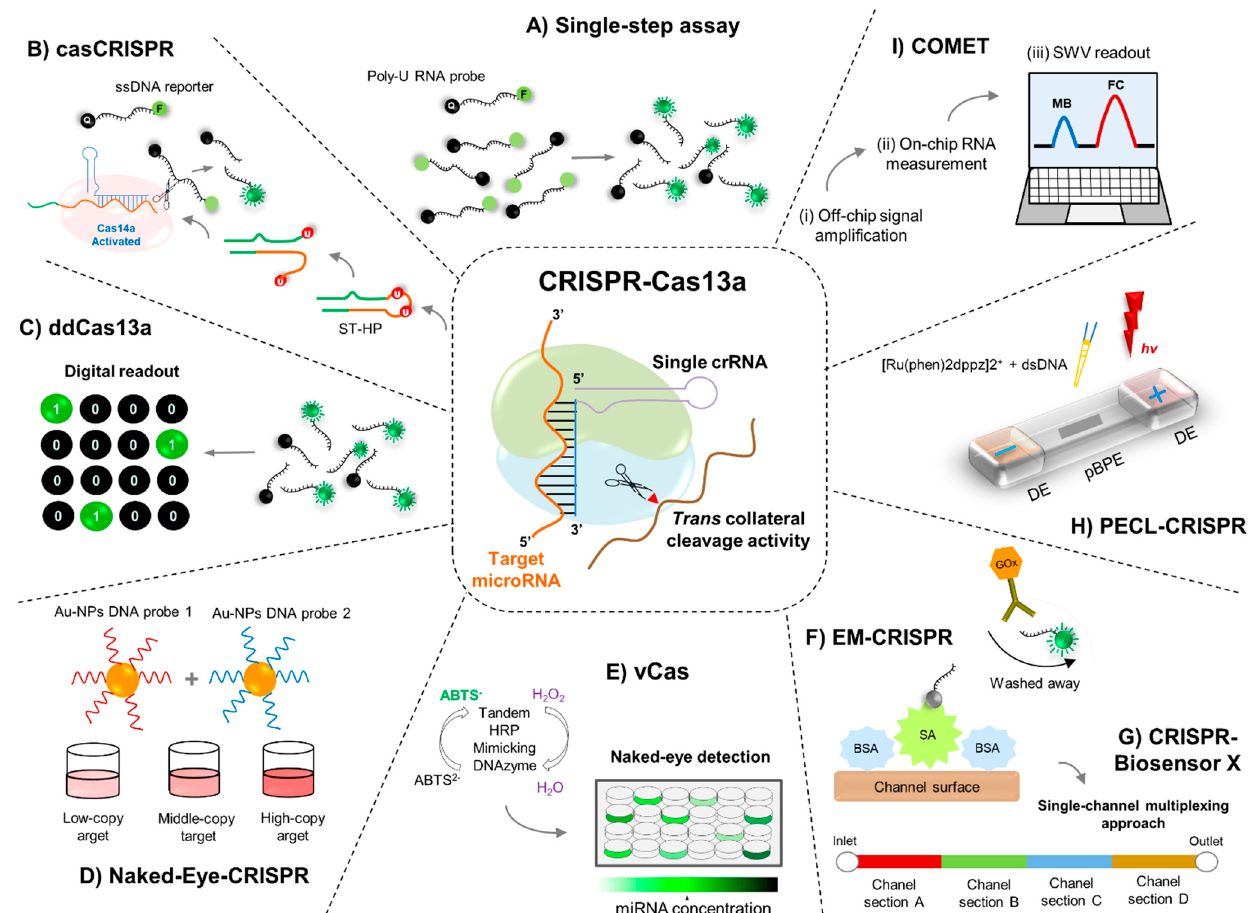
Figure 2. (i) Fluorescence detection platforms . ( A ) In the one-step assay of the Cas13a/crRNA miRNA detection platform, a fluorophore (FAM)- and quencher (BHQ1)-labeled poly-U RNA reporter probe is digested by the Cas13a collateral activity, thus eliminating the fluorescence resonance energy transfer (FRET) effect and releasing fluorescence signals. ( B ) Depiction of the cascade Cas13a–Cas14a (casCRISPR) system for miRNA detection. A locked-trigger for Cas14a/sgRNA (ST-HP) functions as a bridge between Cas13a and Cas14a to serve as the substrate of Cas13a trans -cleavage and triggers the trans ‐ cleavage activity of Cas14a. Thus, the properties of ST ‐ HP are the most critical factor for the performance of cas ‐ CRISPR. C ) Single ‐ molecule miRNA quantification using droplet ‐ digital Cas13a assay (ddCas13a). MiRNAs and a Cas13 mix are emulsified with oil into thousands of picoliter ‐ sized droplets, each containing approximately 0 to 1 molecules of target miRNA. Once recognized by a crRNA, one target miRNA will induce cleavage of 10 4 quenched fluorescent RNA reporters, thus yielding a fluorescently positive droplet. (ii) Colorimetry ‐ based approaches . D ) In the Naked ‐ Eye (NE) ‐ CRISPR/Cas ‐ based colorimetric assay, miRNA target ‐ induced trans ‐ ssDNA (by Cas12a/crRNA) or ssRNA (Cas13a/crRNA) cleavage triggers an aggregation behavior change for the designed AuNPs − DNA probes pair (the AuNPs − DNA probes pair loses the hybridization linkers and becomes dispersed), enabling the completion of naked ‐ eye miRNA detection. E ) Schematic representation of the Cas13a ‐ based visual detection platform vCas. In vCas, the detection results of vCas for miRNAs detection can be estimated by the naked eye, or the absorbance at 405 nm can be measured using a microplate reader. (iii) Electrochemical detection Platforms . F ) In the EM ‐ CRISPR assay (on ‐ chip miRNA detection), the signal obtained from the enzymatic readout (amperometric signal) reflects the amount of immobilized glucose oxidase (GOx) ‐ conjugated and is, therefore, inversely proportional to the target concentration in the sample. Bovine serum albu ‐ min (BSA) prevents unspecific adsorption of biomolecules. G ) The CRISPR ‐ Biosensor X implements different multiplexed versions of the previous electrochemical microfluidic biosensor (microfluidic multiplexed lab ‐ on ‐ a ‐ chip device) by divid ‐ ing its channel into subsections, creating four novel chip designs for the amplification ‐ free and simultaneous quantifica ‐ tion of up to eight miRNAs. H ) In the PECL ‐ CRISPR chip, the electrochemiluminescence signals on a bipolar electrode (BPE) directly indicate the oxidation reaction of [Ru(phen)2dppz]2 + ‐ DNA complex at the anode of BPE and are propor ‐ tional to target miRNA concentration, thereby enabling quantitative miRNA detection. I ) The COMET chip assay is com ‐ posed of off ‐ chip signal amplification (i), on ‐ chip RNA measurements (ii), and square wave voltammetry (SWV) readout